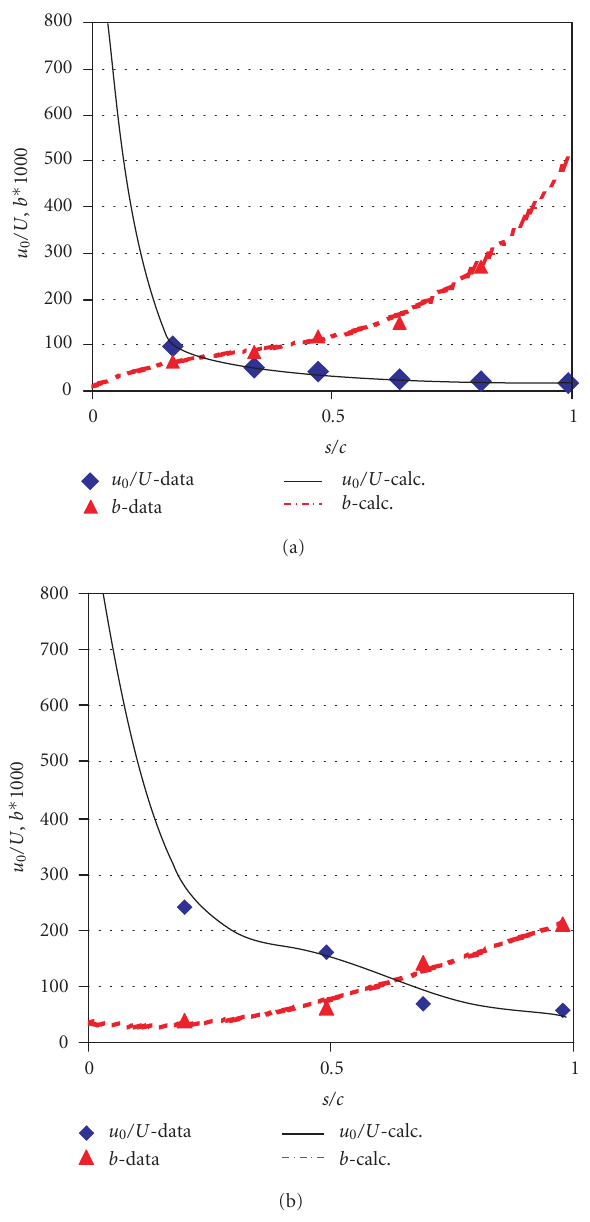
Figure 4: Measured and calculated velocity defects and wake width for cascades tested by Kurz [5]: (a) t/c = 0 . 877 and M ∗ = 0 . 96, and (b) t/c = 0 . 822 and M ∗ = 0 .